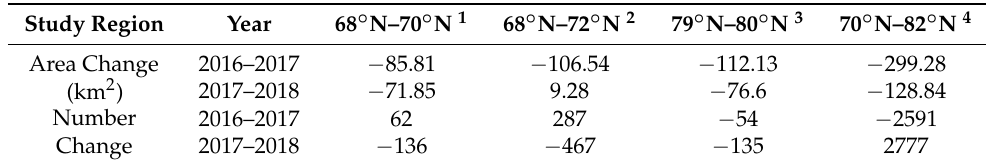
Table 4. Comparison within partial areas (CW, NE region) of the SGL evolution in Greenland from 2016 to